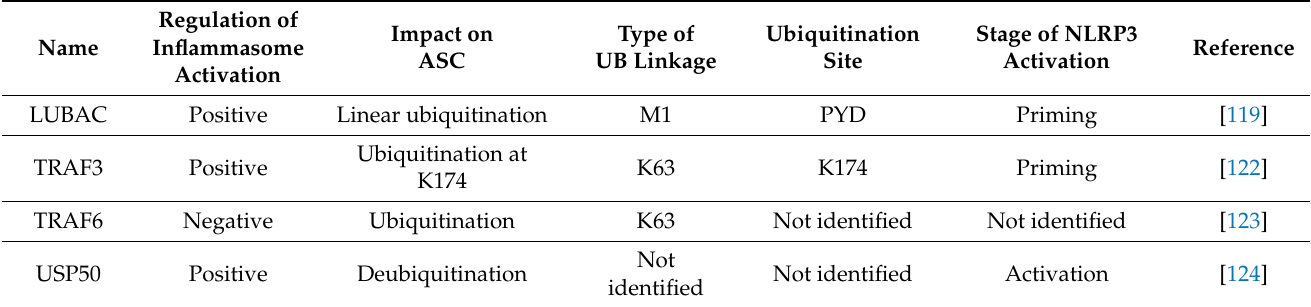
Table 3. Regulation of ASC by E3 ligase and